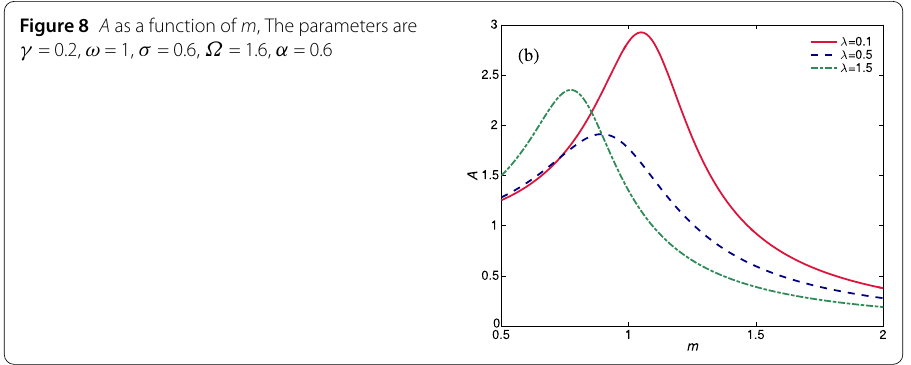
Figure 8 A as a function of m , The parameters are γ = 0.2, ω = 1, σ = 0.6, Ω = 1.6, α =